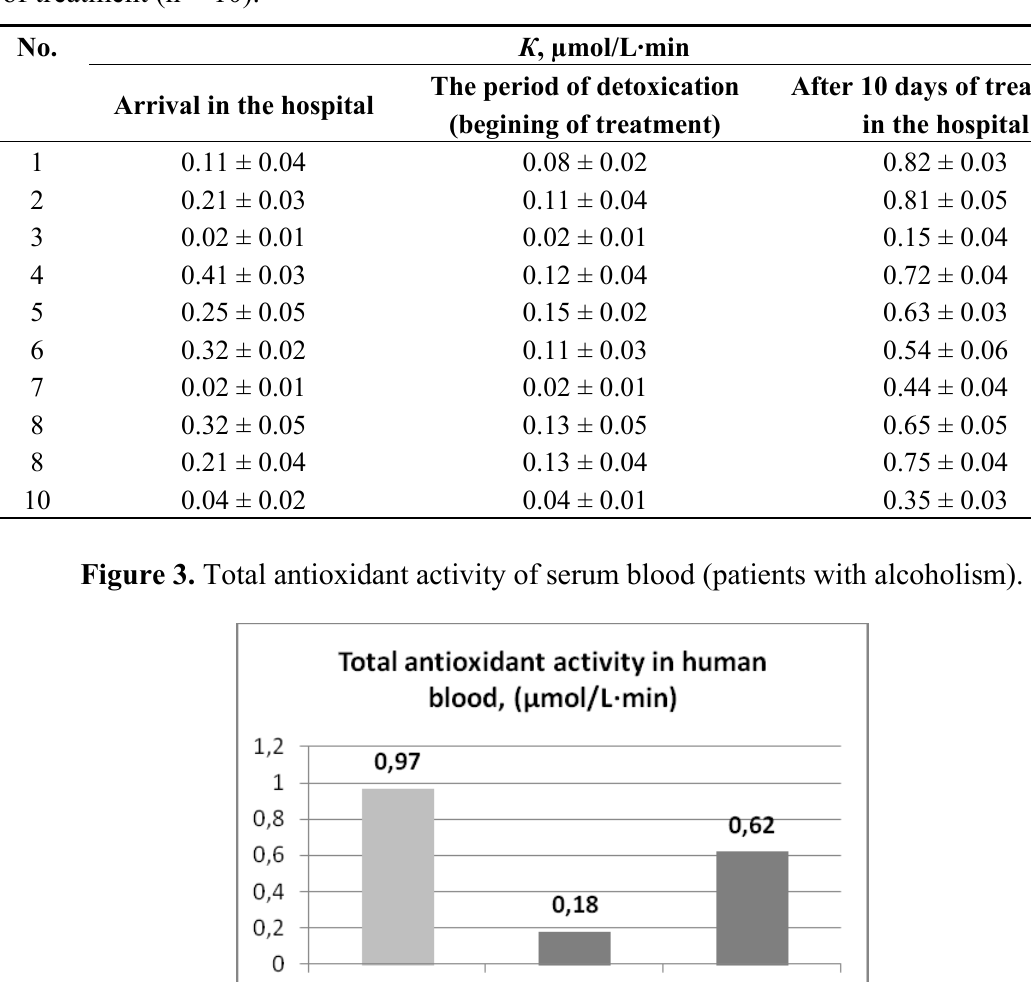
Table 3. Values of the TAA of serum blood of patients with alcoholism at different stages of treatment (n = 10).